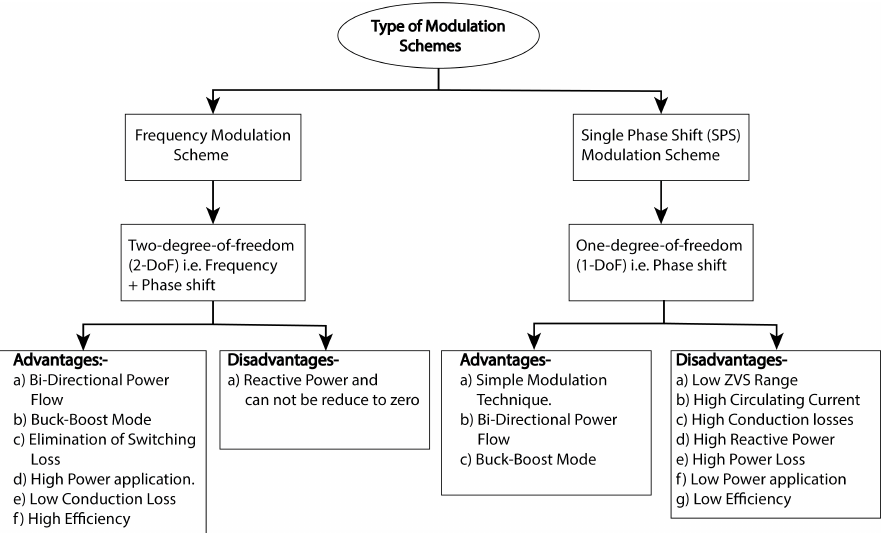
Figure 4. Comparison between the frequency modulation and single-phase shift (SPS) modula- tion techniques.